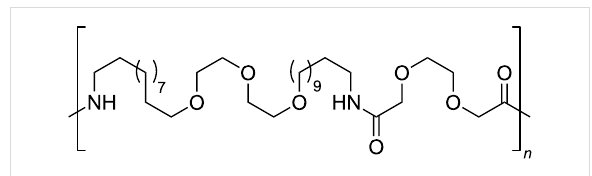
Figure 20: Polymer comprising α -oxydiacid